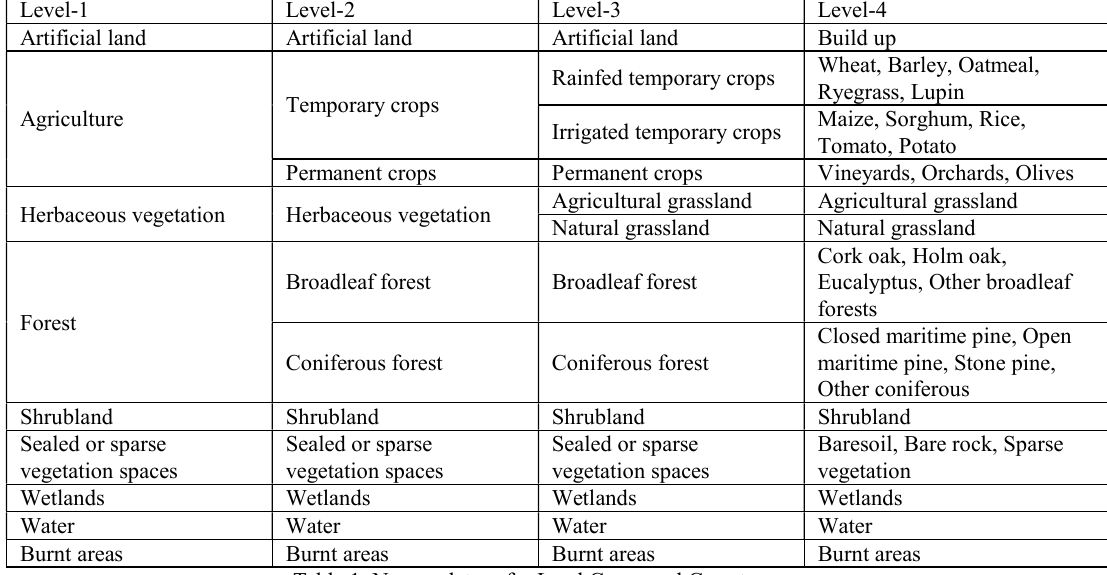
Table 1. Nomenclature for Land Cover and Crop type map